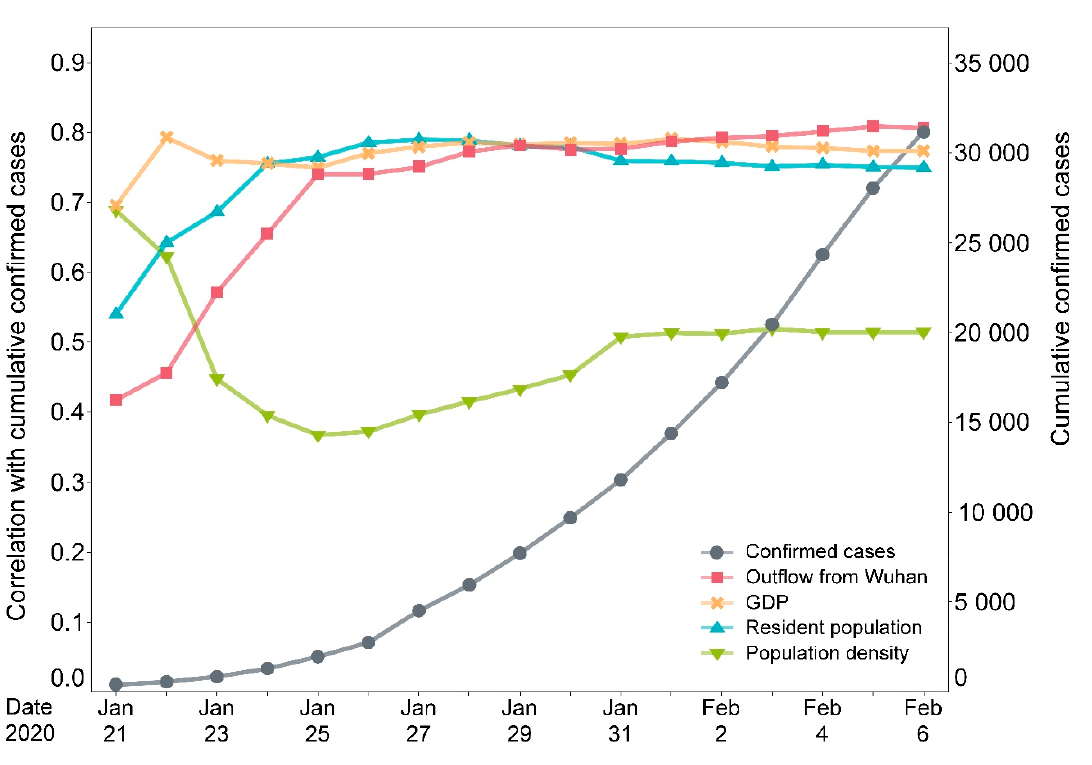
Table 3. Association between cumulative confirmed COVID-19 cases and other socioeconomic variables according to multivariate regression model.